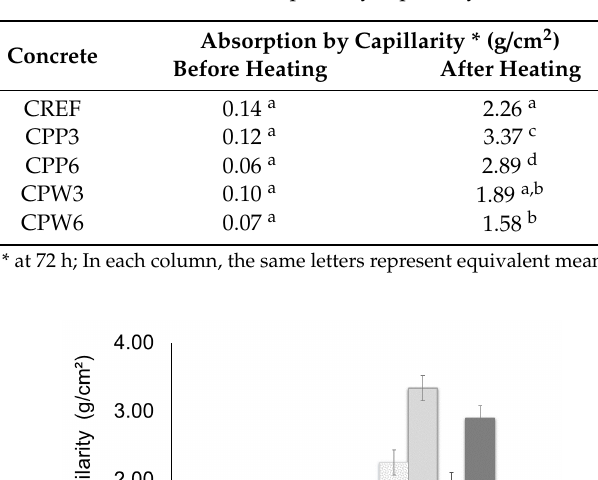
Table 7. Absorption by capillarity.